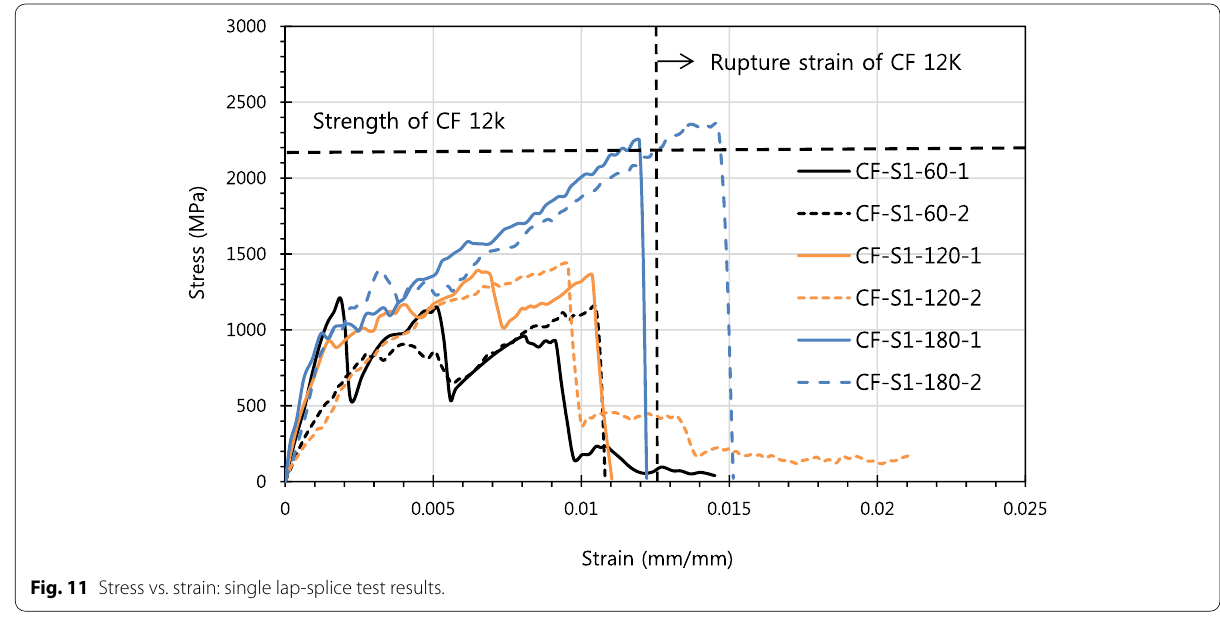
Fig. 11 Stress vs. strain: single lap-splice test results.